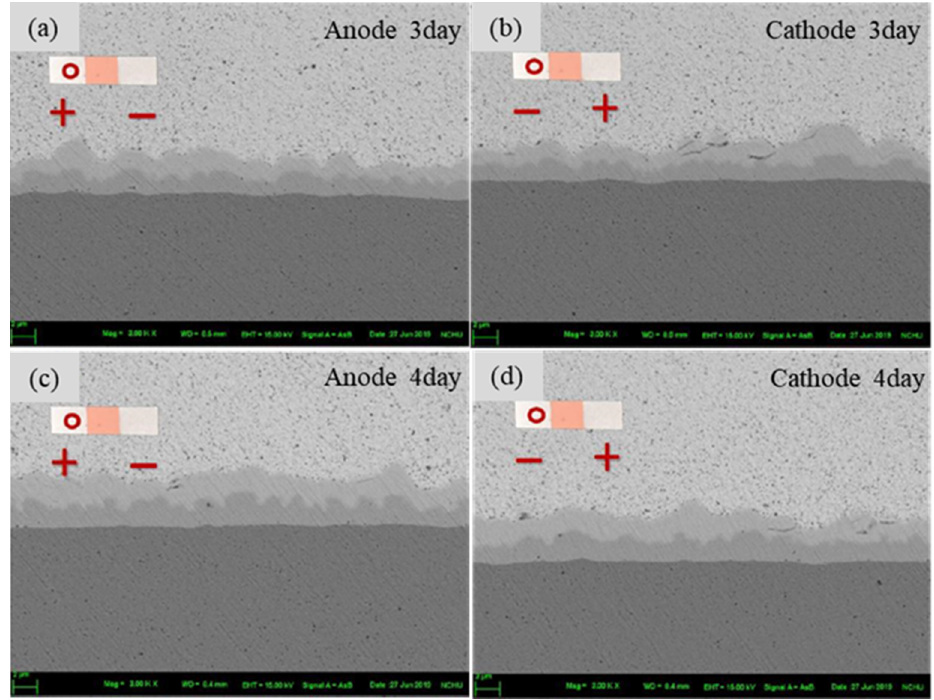
Figure 9. SEM images of 5:5 sample heated at 130 °C and subjected to a current of 0.8 A. ( a ) Anode side (indicated on red circle) for 3 days; ( b ) Cathode side for 3 days; ( c ) Anode side for 4 days; ( d ) Cathode side for 4 days. Table 3. The IMC formation and their corresponding thickness in the sample heated at 130 °C and subjected to a current of 0.8 A.